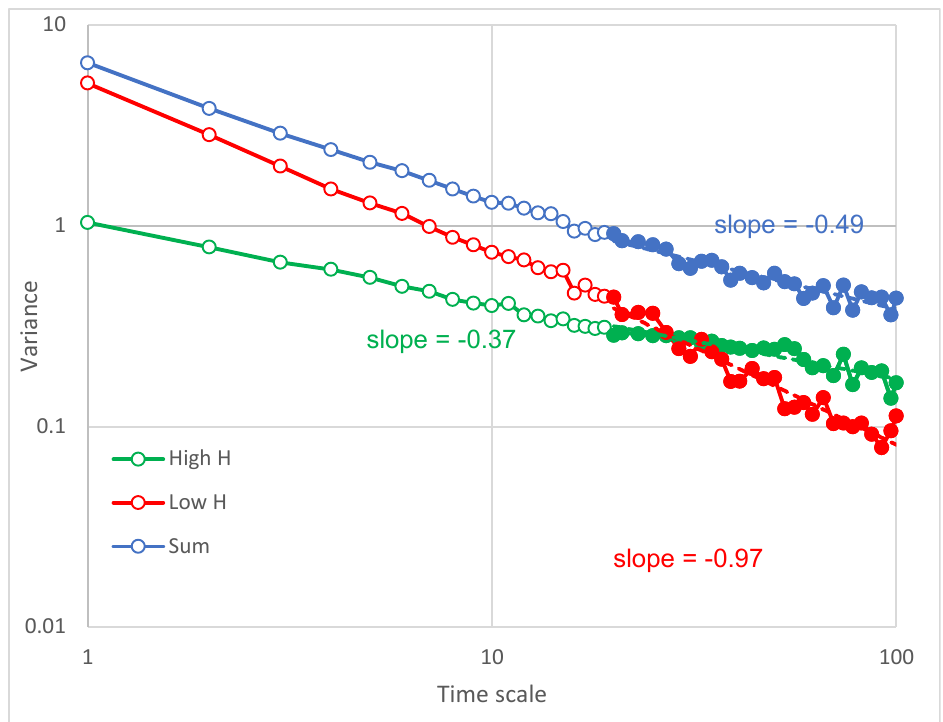
Figure 3. Monte Carlo simulation of the scale dependence of H for the sum of two HK processes with different H parameters.